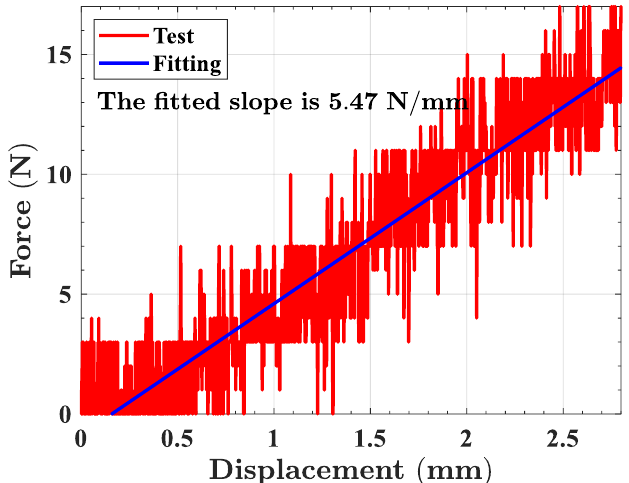
Figure A4. The displacement and tensile test results of the optical fibers. The length of the tested optical fiber was 188 mm and the diameter was 125 µ m [27]. Additionally, the elastic modulus and tensile stiffness of the optical fiber can be calculated as 83.8 GPa and 1028 N. The tensile stiffness of the Fe 78 Si 13 B 9 ribbons is greater than that of optical fiber. The strain of the Fe 78 Si 13 B 9 ribbons caused by magnetic field can be measured by optical